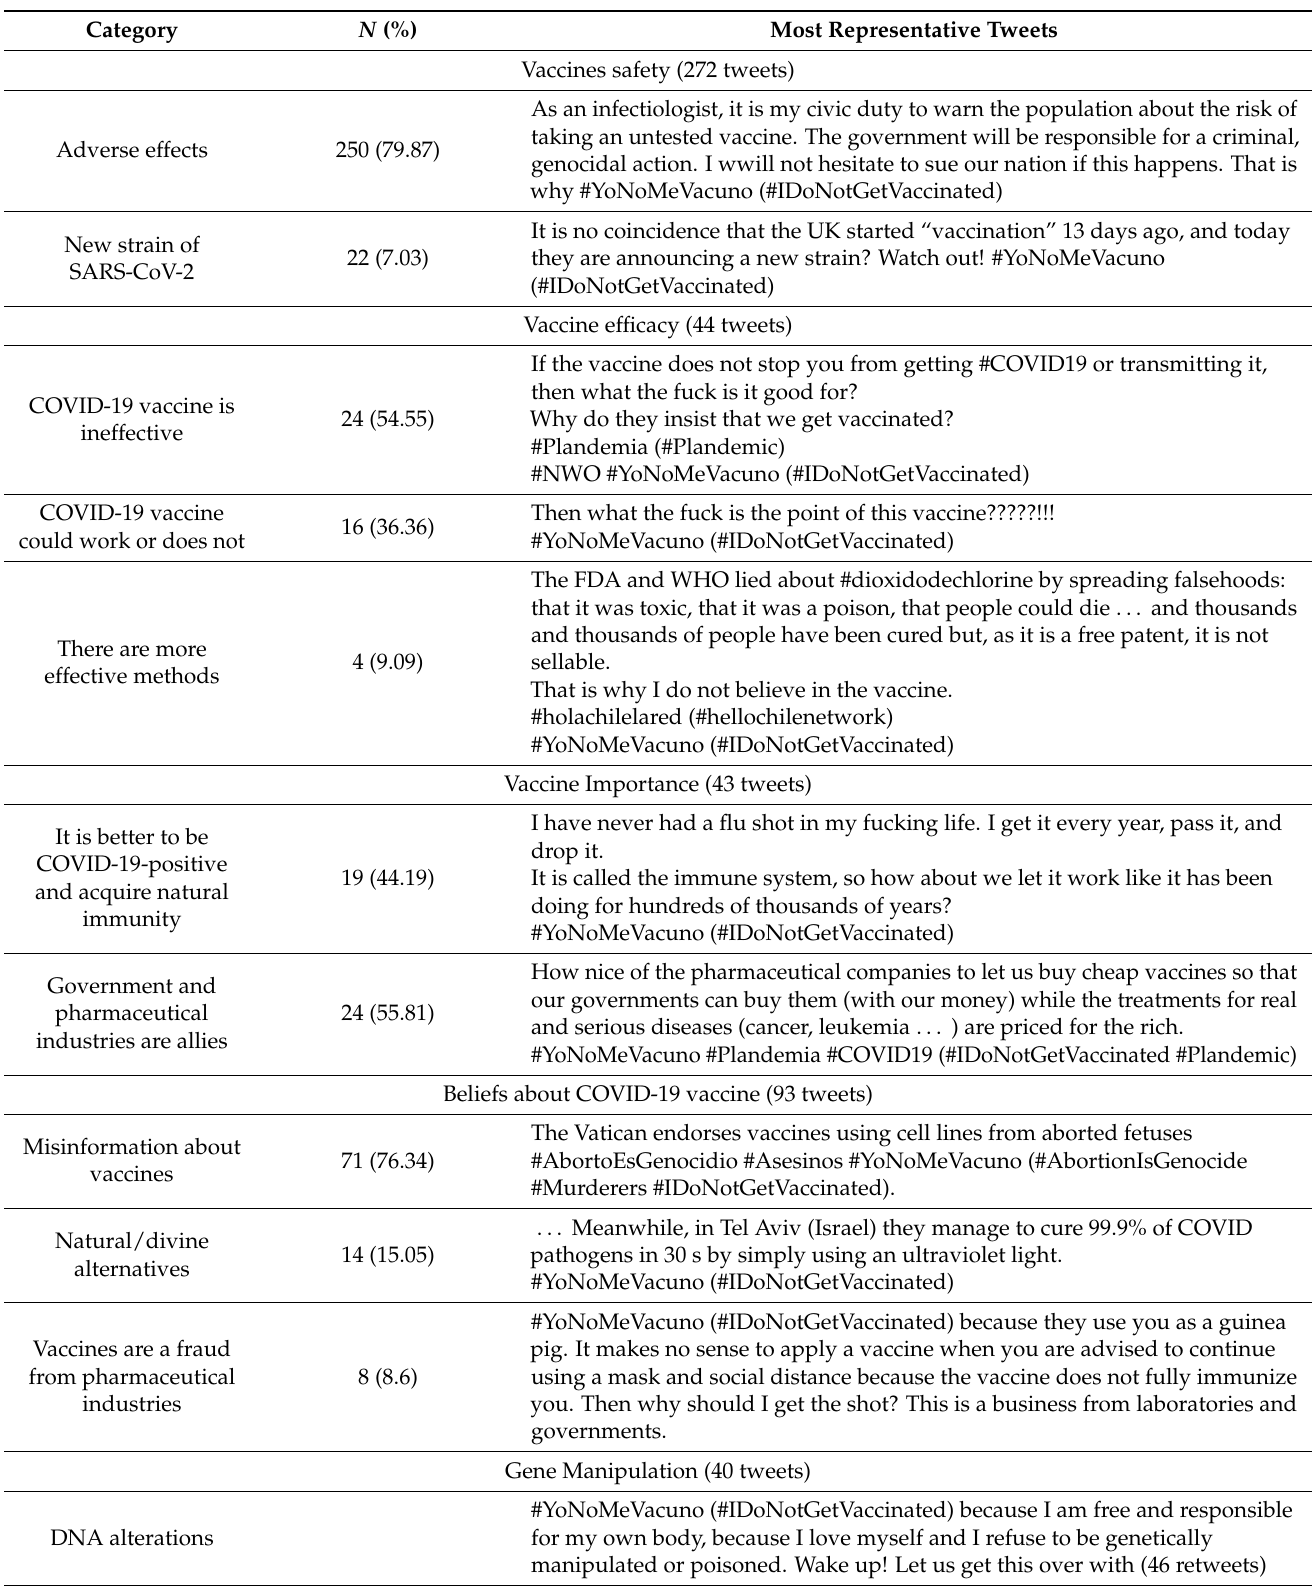
Table 4. Categories of anti-COVID-19 vaccine tweets and more representative tweets (most retweeted). (Note: The tweets have been transcribed